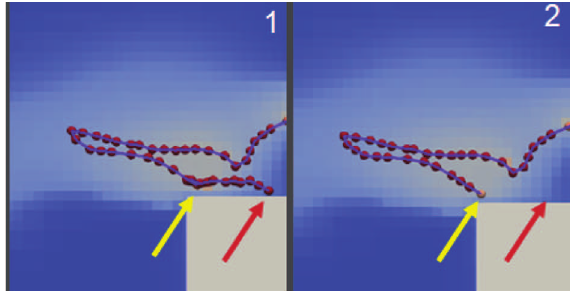
Fig. 3. Truncation of spark channel between frames 1 and 2, when a center Lagrangian particle gets too close to the lower electrode surface. Red and yellow arrows denote the location of the old and new end particles,